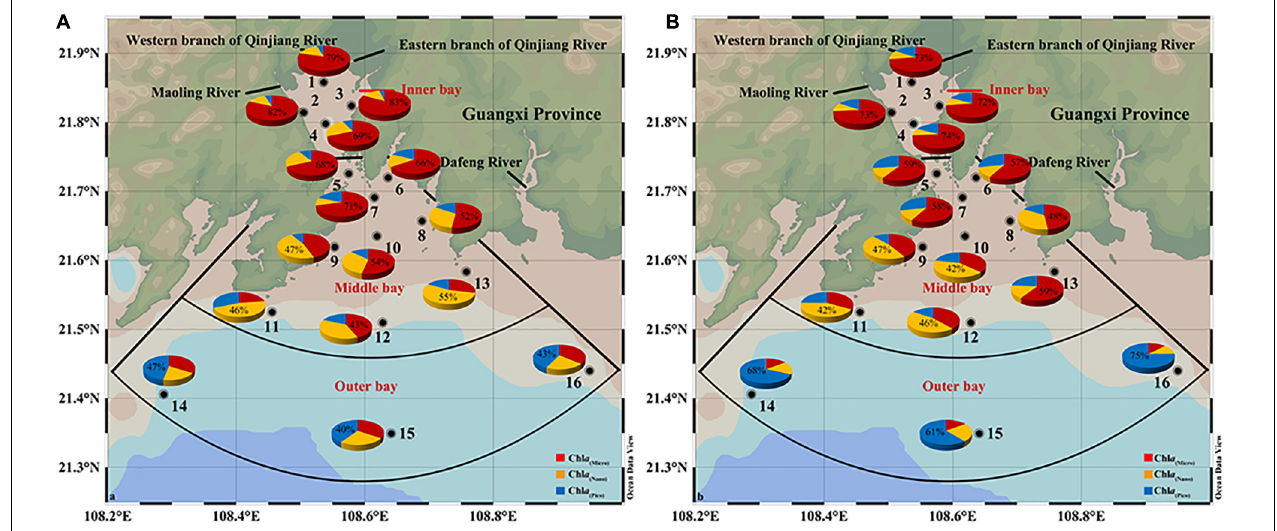
FIGURE 7 | The percentage of size-fractionated chlorophyll a (Chl a ) in total Chl a during SW (A) and NE (B) monsoon in the Qinzhou